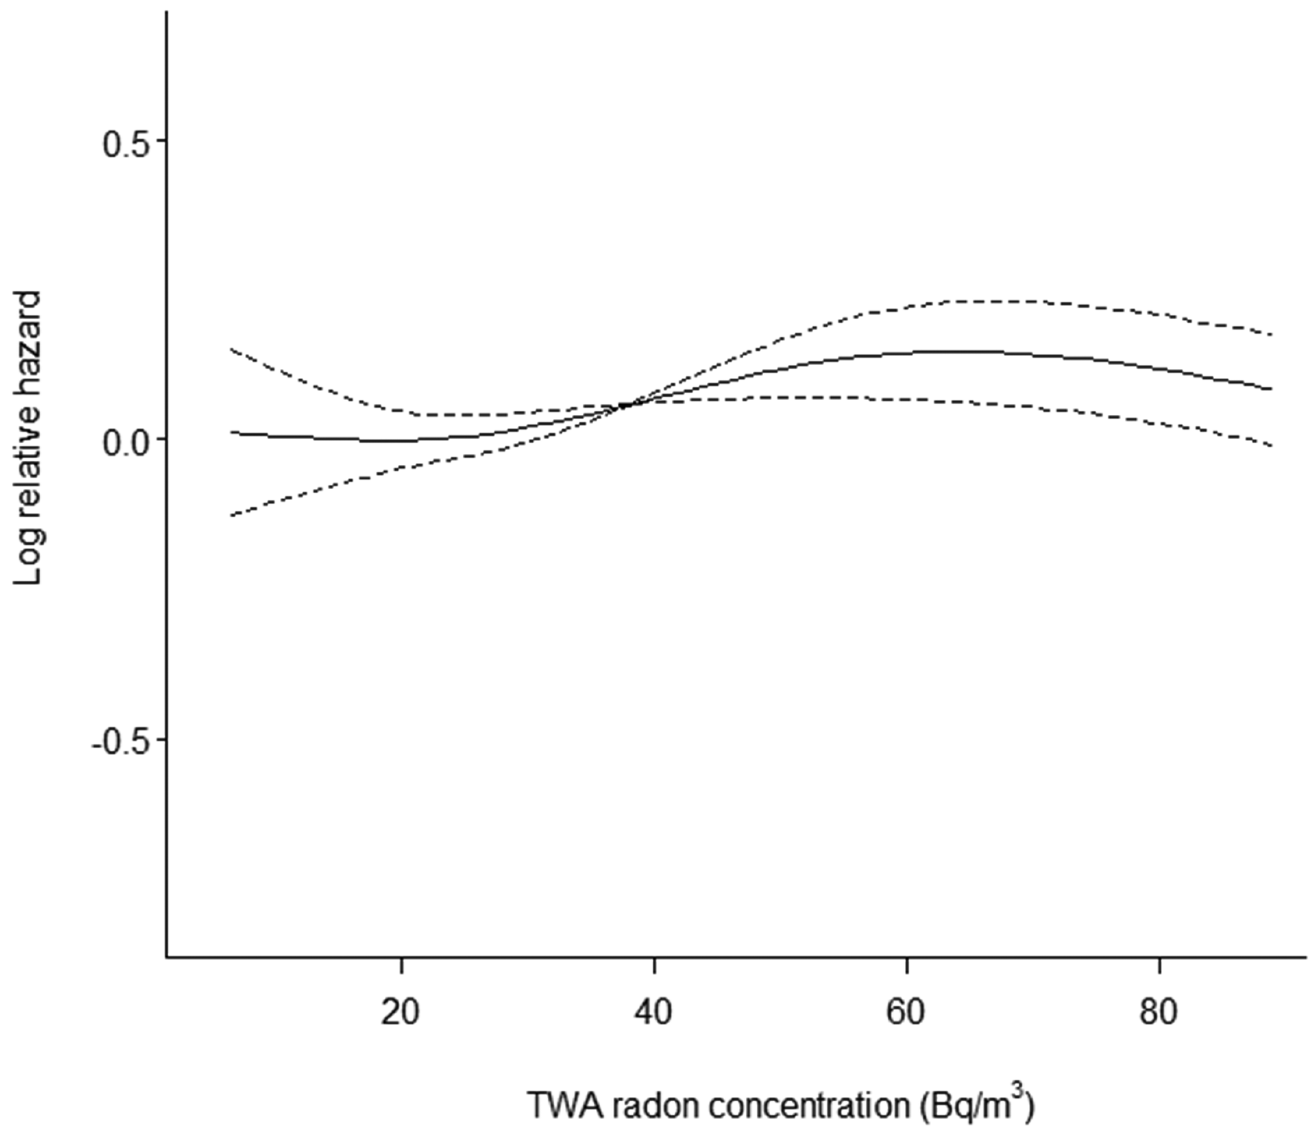
Fig 1. Spline functions (filled lines; 95% CIs indicated by dashed lines) between BCC and average residential radon concentration (Bq/m 3 ) at the residencies from 1971 onwards, based on the fully adjusted model 2 and cohort participants with exposure between 5 th and 95 th